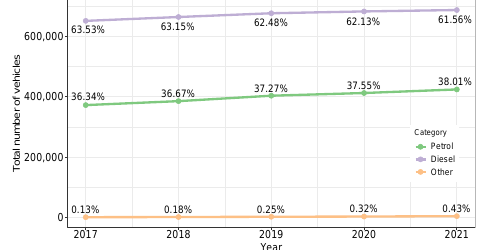
Figure 12. Total number of vehicles according to the category during the period of 2017–2021 in circulation in the Region of Murcia. The percentages of each type of vehicle were obtained for each year. Source: Dirección General de Tráfico,